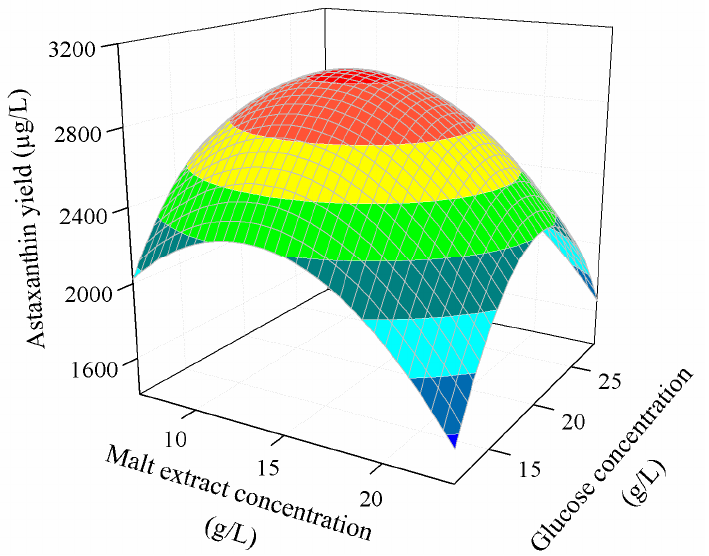
Figure 5. Combined e ff ect of malt extract concentration and glucose concentration on astaxanthin production by R. toruloides mutant.